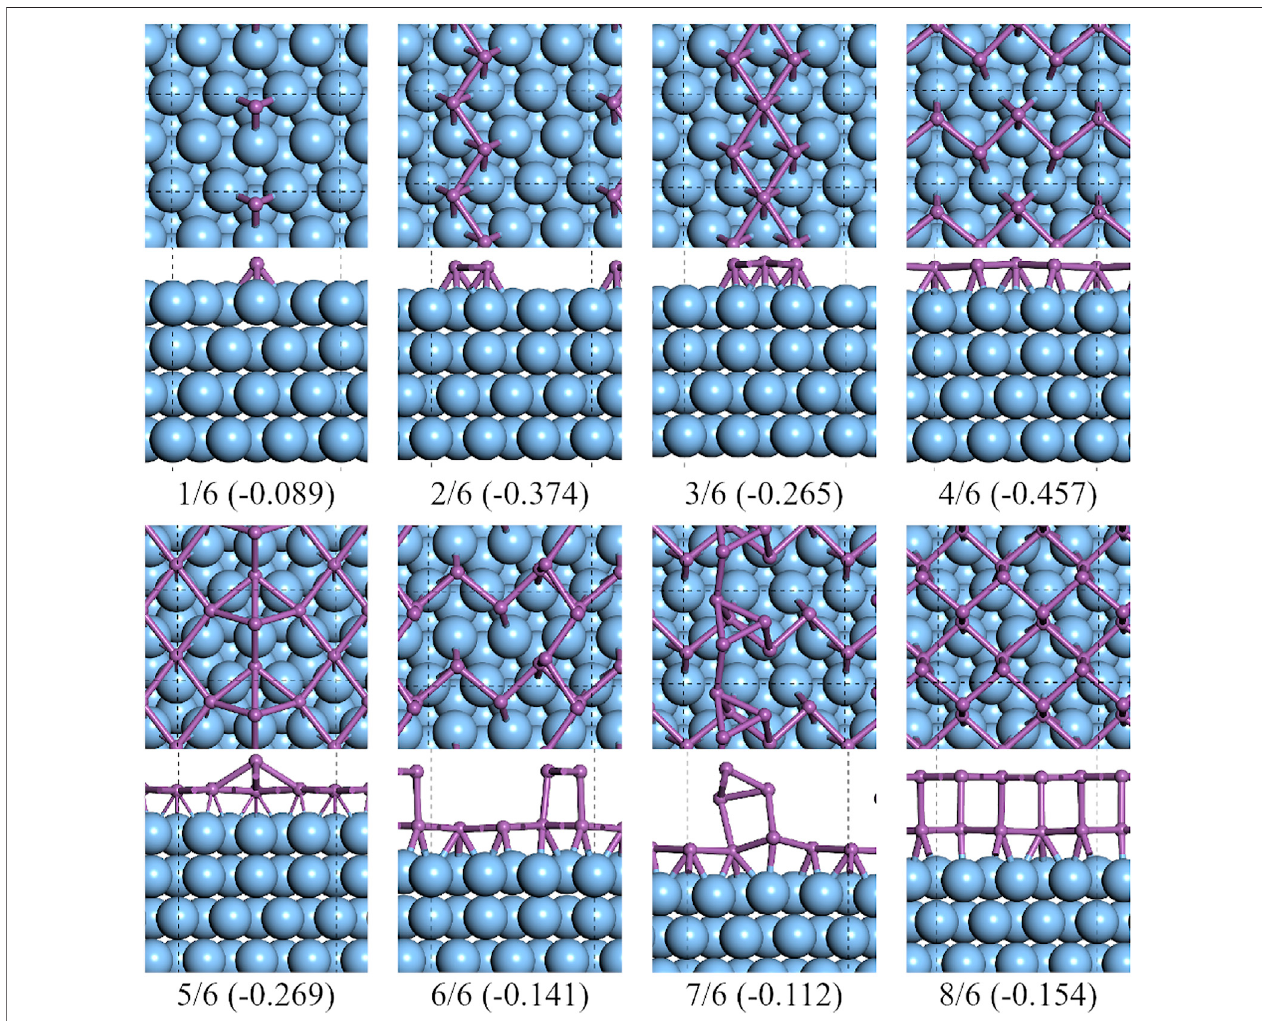
(cid:1)(cid:1) √ 3 Ag (111) surface.